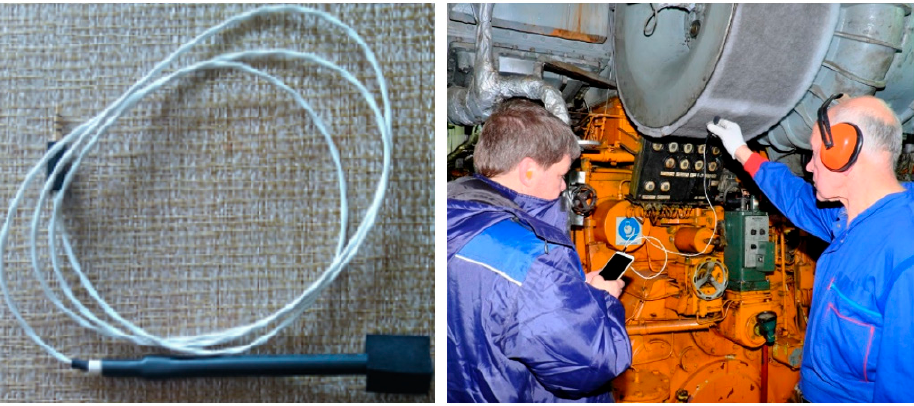
Figure 4. Recording the vibration of the turbocharger using the EM-4015-BC electret